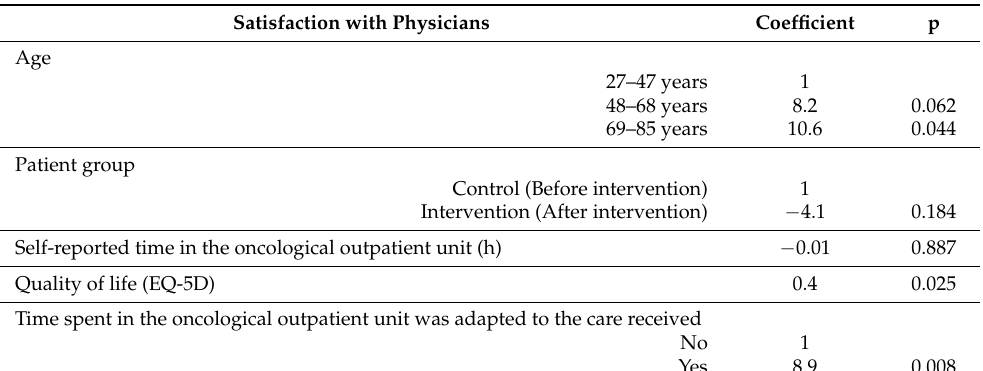
Table 3. Factors associated with satisfaction with physicians: Multiple linear regression analysis ( N =